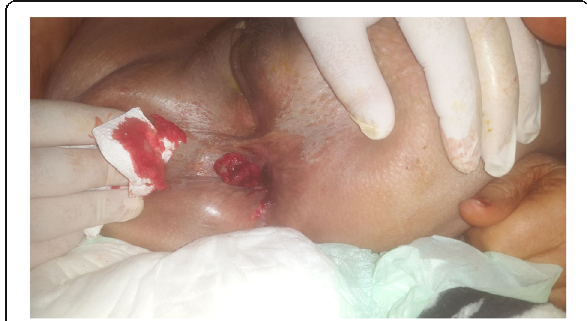
Fig. 1 A budding lesion 2 cm on the right of the anal verge, developing from the perianal skin, without continuity with the coloanal anastomosis